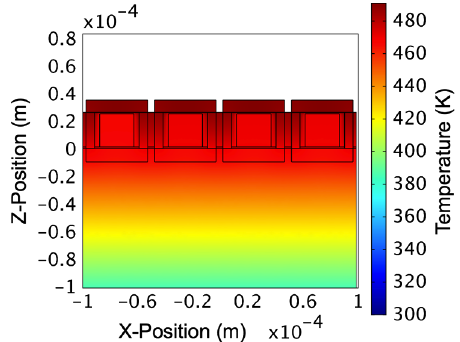
FIG. 17. Temperature distribution simulation (Kelvin) of a ¼ 100 (cid:1) m undulator winding cross section driven with (cid:2) u 0.8 A, producing 0.3 T, fabricated on a 200 (cid:1) m thick Si